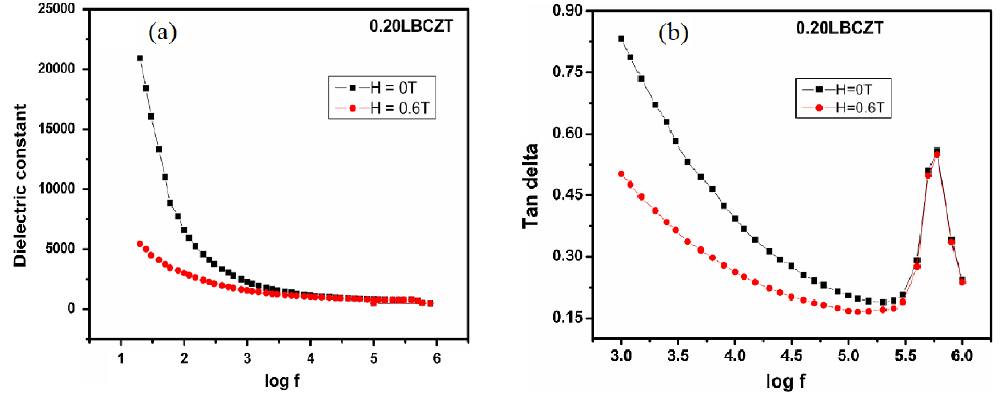
Figure 7. ( a ) Variation of ε as a function of logf for 0.20LBCZT Heterostructure. ( b ) Variation of tanδ as a function of logf for 0.20LBCZT with and without applied magnetic field (H). Reprinted with permission from [51]. Copyright 2016 Springer Nature.